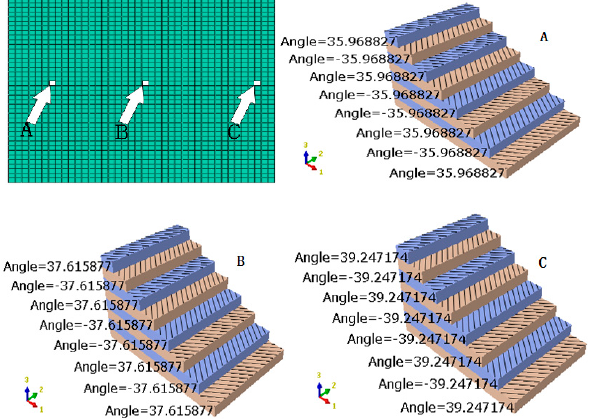
Figure 5. Schematic of the element angle in a variable-angle laminate. ( A ) Arbitrary unit A; ( B ) Arbitrary unit B; ( C ) Arbitrary unit C.